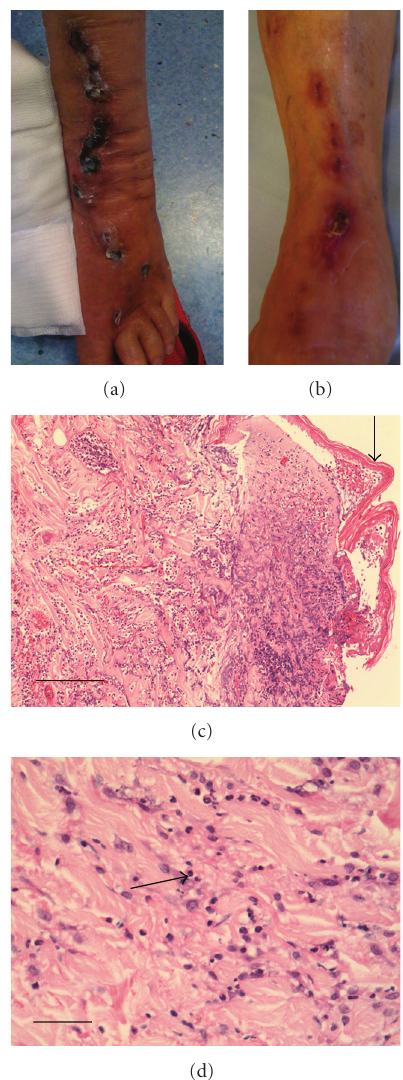
Figure 1: Clinicopathologic features of Sweet syndrome in our patient at diagnosis: (a) Photograph showing the purpuric patches and pustulovesicular lesions over the left leg and dorsum of foot at diagnosis. (b) Photograph showing the resolving skin lesions over the left leg and dorsum of foot at the time of writing the manuscript. (c) Low power H & E of skin showing di ff use infiltrate of dermis and superficial subcutis with neutrophils (arrow). There is incipient necrosis of the epidermis. Dimension bar (left lower corner) 250 microns. (d) High power H & E of skin—the arrow shows focal leukocytoclasis without vasculitis—dimension bar (left lower corner) 50